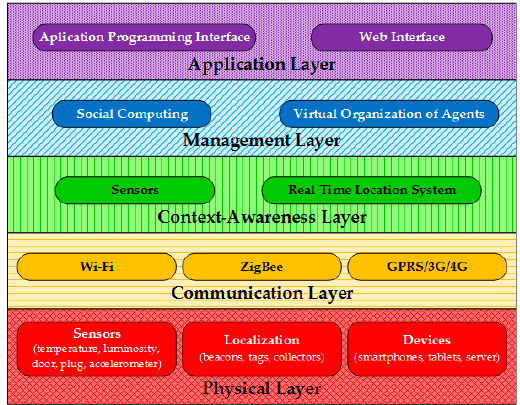
Figure 2. CAFCLA (Context-Aware Framework for Collaborative Learning Applications) layers diagram and the devices and technologies implemented within each of them for this use case.